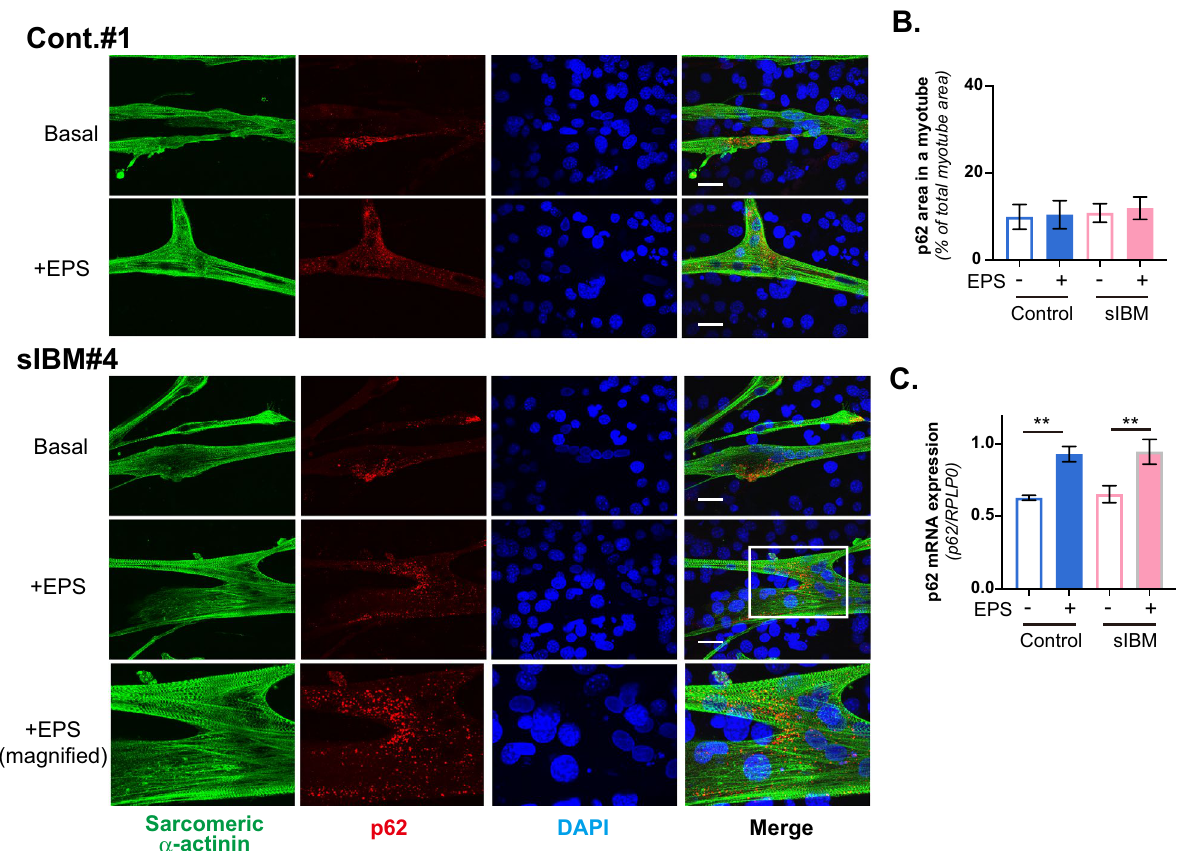
Figure 5. Subcellular localization of p62 in myotubes of feeder-supported in vitro exercise model. ( A ) Six human myotube preparations originating from 3 healthy control subjects (Cont. #1–#3) and 3 sIBM patients (sIBM#4–#6) were subjected to immunofluorescent staining analysis. After 7–8 days of differentiation, the differentiated human myotubes on the feeder layers of mouse 3T3L1 fibroblasts were subjected to EPS treatments, fixed and then observed for subcellular localization of p62 by using anti-p62 and anti-sarcomeric- α-actinin antibodies, as described in the “Methods” section. DAPI was used for nuclear staining. Scale bar = 25 μm. Three independent experiments were performed, and one healthy control and one sIBM myotube are each presented are presented as the representative images. A magnified image of the white box (sIBM myotubes + EPS) is also presented ( the bottom panels ). Scale bar = 25 μm. ( B ) For quantification, 5 different fields in the images (of which each field usually contained 6–12 myotubes) were taken and the p62 puncta area to the total area of a myotube was calculated, as described in the “Methods” section. Quantification of the ratio of the p62 area to the total myotube area was determined from more than 60 myotubes in three independent experiments using the same cell stock samples. The statistical significance of differences was analyzed using ANOVA with Dunnett’s multiple comparison test. ( C ) Total RNA was extracted and mRNAs for human p62 and RPLP0 were evaluated by real-time PCR analysis. Data were normalized using human RPLP0 transcripts. The graph shows the results of three independent experiments using the same cell stock samples (healthy control and sIBM myotubes, n = 3 each, ** p <